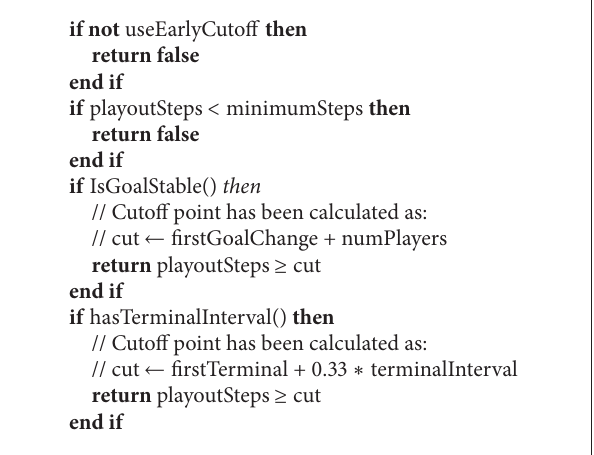
Algorithm 1: Pseudo-code for deciding cuts for the early cutoff extension. It was taken from